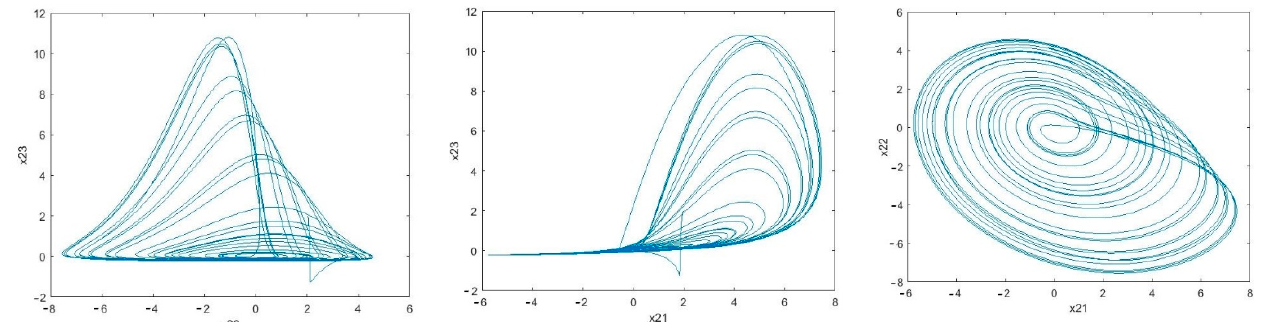
Figure 6. Sample phase curves of the Master system.